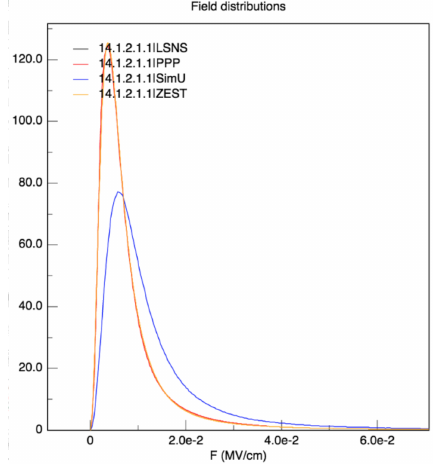
Figure 10. The electric field distributions as calculated by the different line shape codes for the lowest electron density and temperature n e = 10 15 cm − 3 and T e = T i = 0.1 eV. These concern ions only for LSNS, PPP, and ZEST codes. The SimU distribution represents that of the total electric field, that is, the ions and